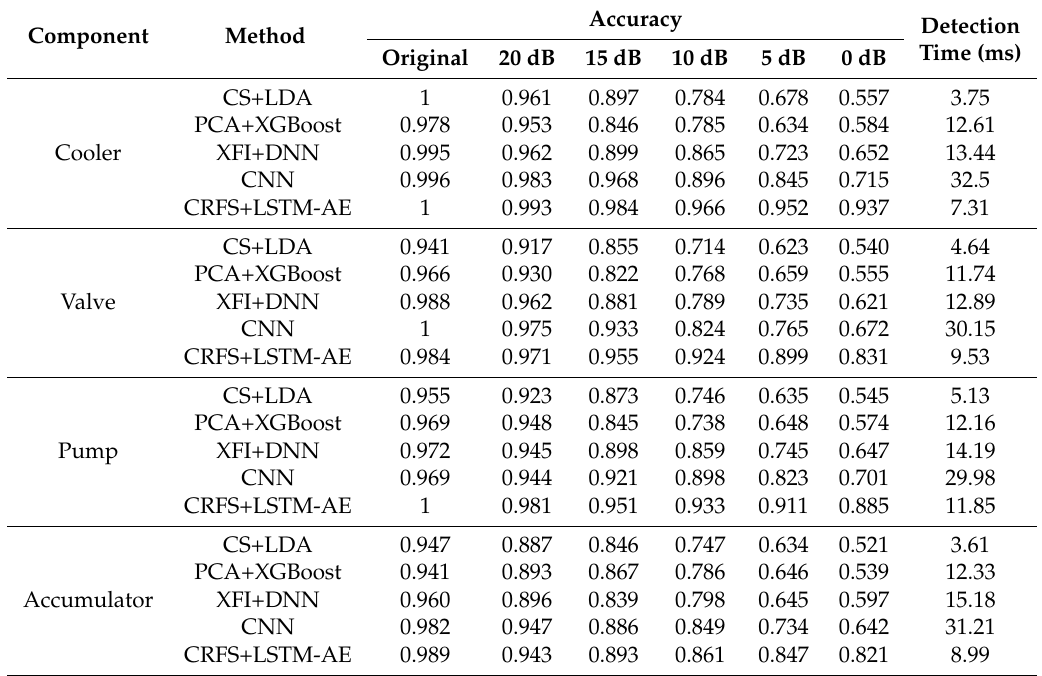
Table 8. Comparison to previous